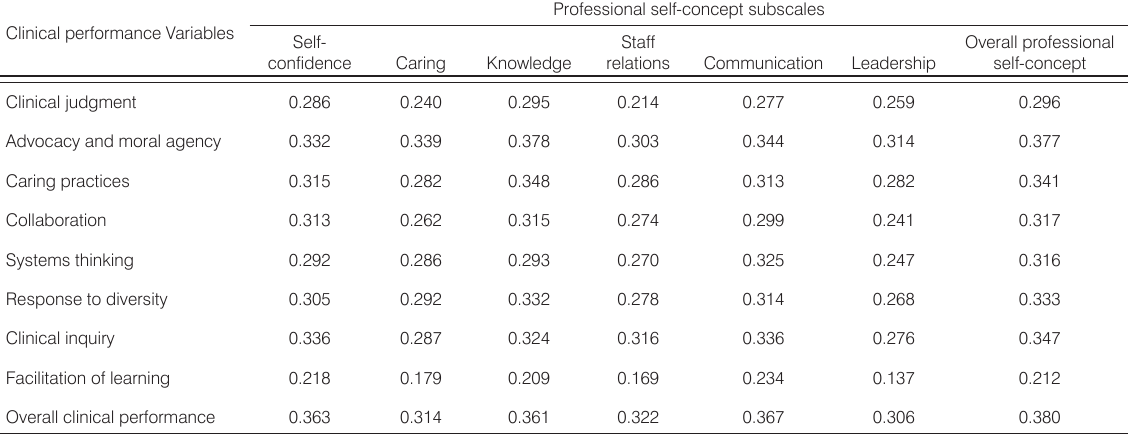
Clinical performance Variables